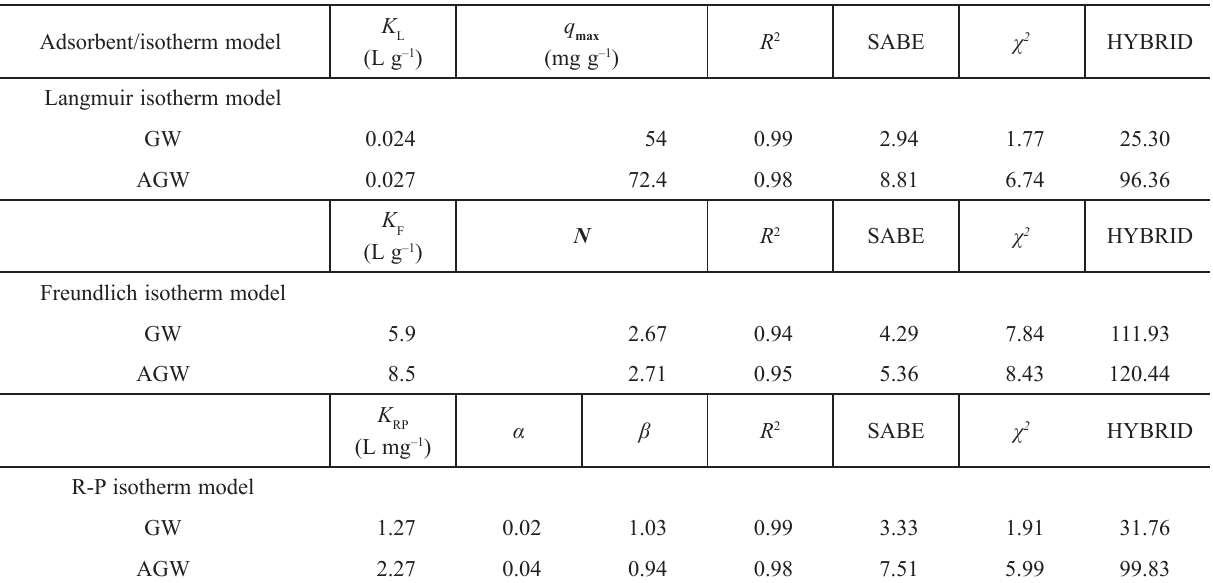
Table 5 – Isotherm model parameters and error analysis for GW and AGW Adsorbent/isotherm model